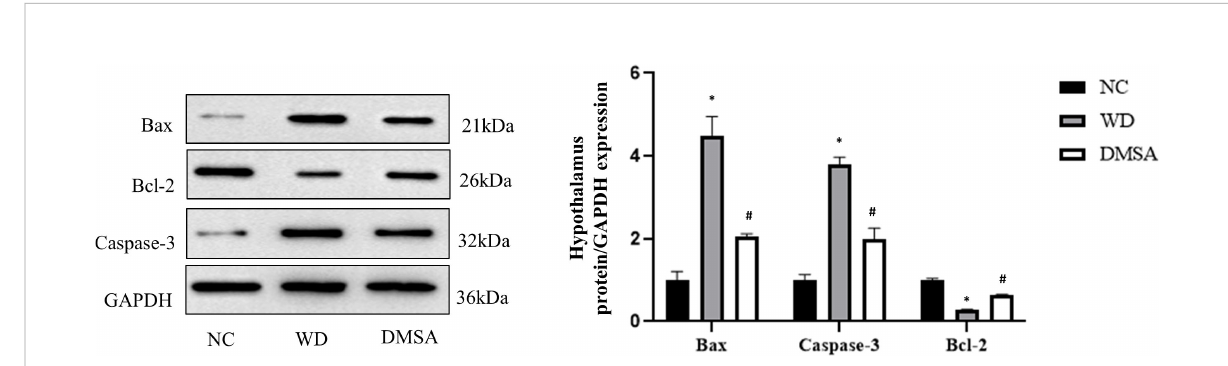
FIGURE 7 Expression levels of Bax, Caspase-3 and Bcl-2 proteins in the male hypothalamus. Data are presented as mean ± SD.(*P<0.05, NC group vs. WD group; # P<0.05, WD group vs. DMSA group).